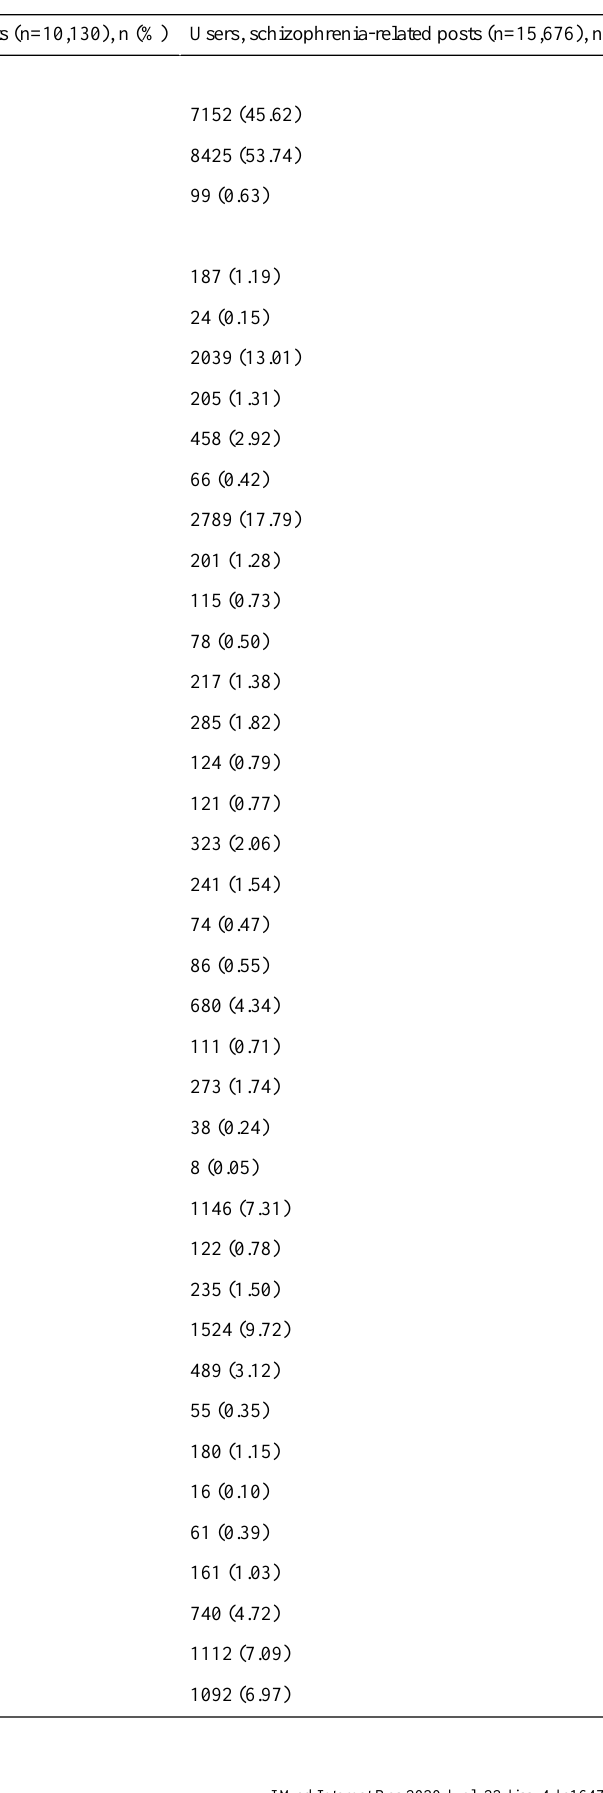
Table 1. Demographics of included